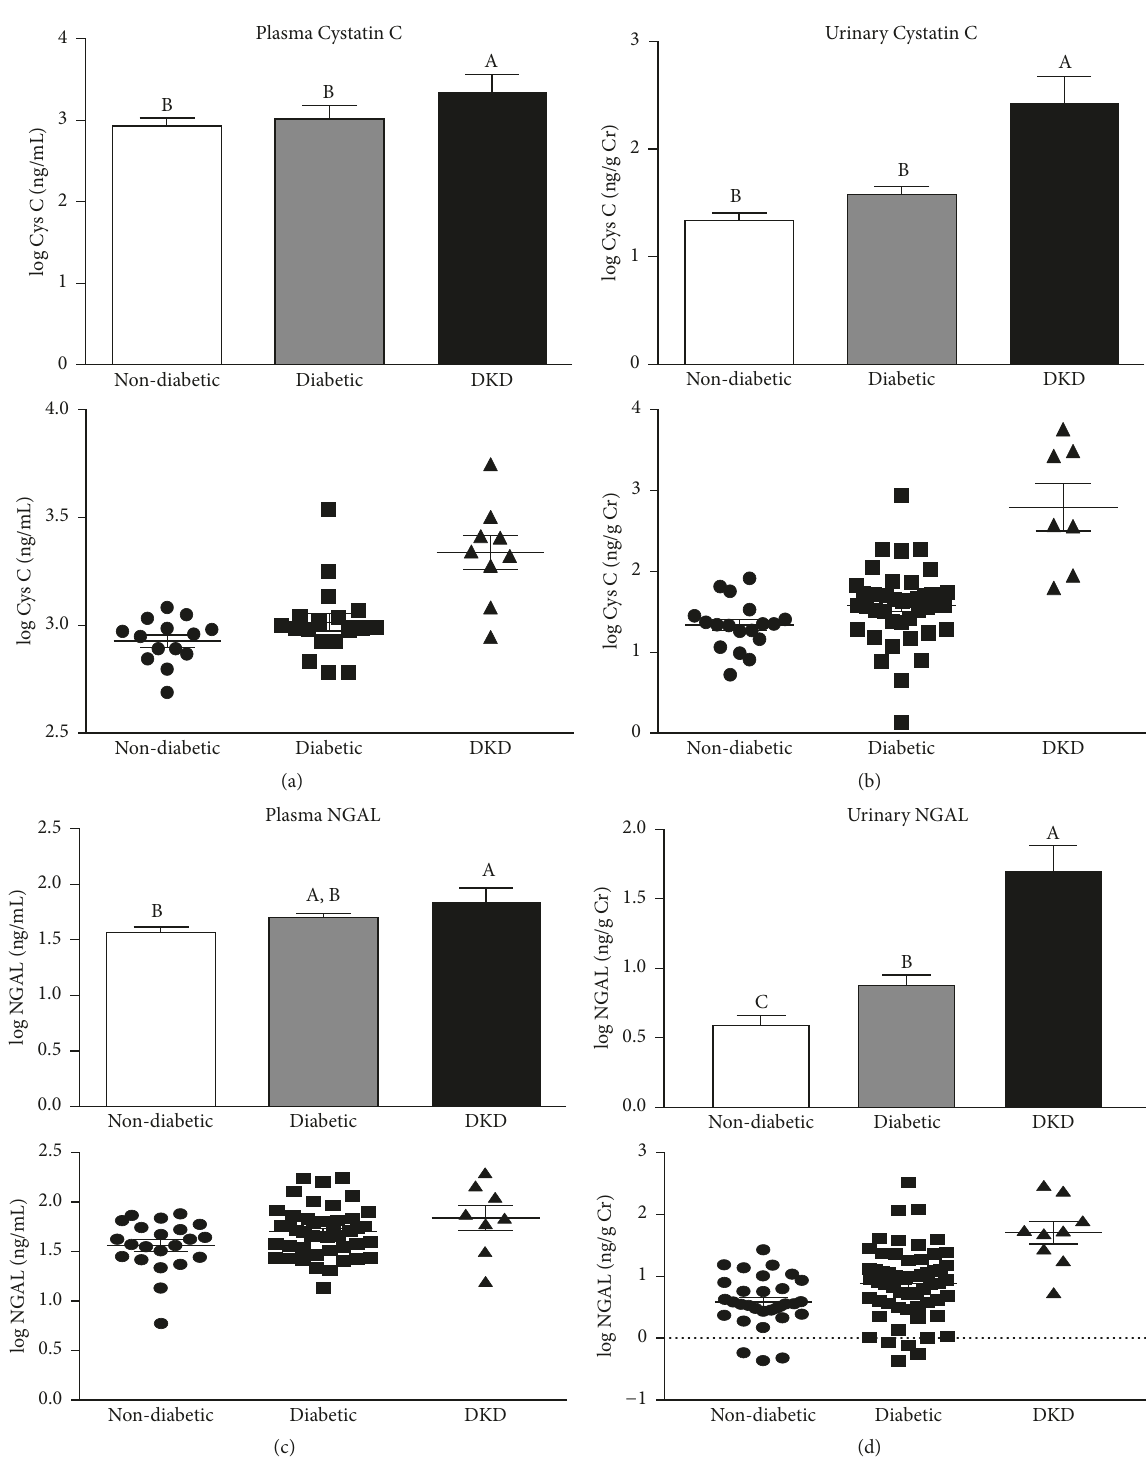
Figure 5: Cystatin C and neutrophil gelatinase-associated lipocalin (NGAL) levels based on clinical diagnosis status. (a)-(b) Log-transformed plasma (a) or urinary (b) cystatin C levels among nondiabetic subjects, diabetic patients with no known kidney disease (diabetic), and patients with diagnosed diabetic kidney disease (DKD). Urinary cystatin C levels were normalized to urinary creatinine to account for differences in urine concentration. Data are represented as both a bar chart showing mean log Cystatin C ± SEM within each group (top) and a scatter plot showing values for each individual within the group (bottom). (c)-(d) Log-transformed plasma (c) and (d) urinary NGAL levels among nondiabetic subjects, diabetic patients with no known kidney disease (diabetic), and patients with diagnosed diabetic kidney disease (DKD). Urinary NGAL levels were normalized to urinary creatinine to account for differences in urine concentration. Data are represented as both a bar chart showing mean log NGAL ± SEM within each group (top) and a scatter plot showing values for each individual within the group (bottom). Labeled means without a common letter are significantly different from one another (𝑝 < 0.05) based on one-way ANOVA and Tukey’s honest significant difference